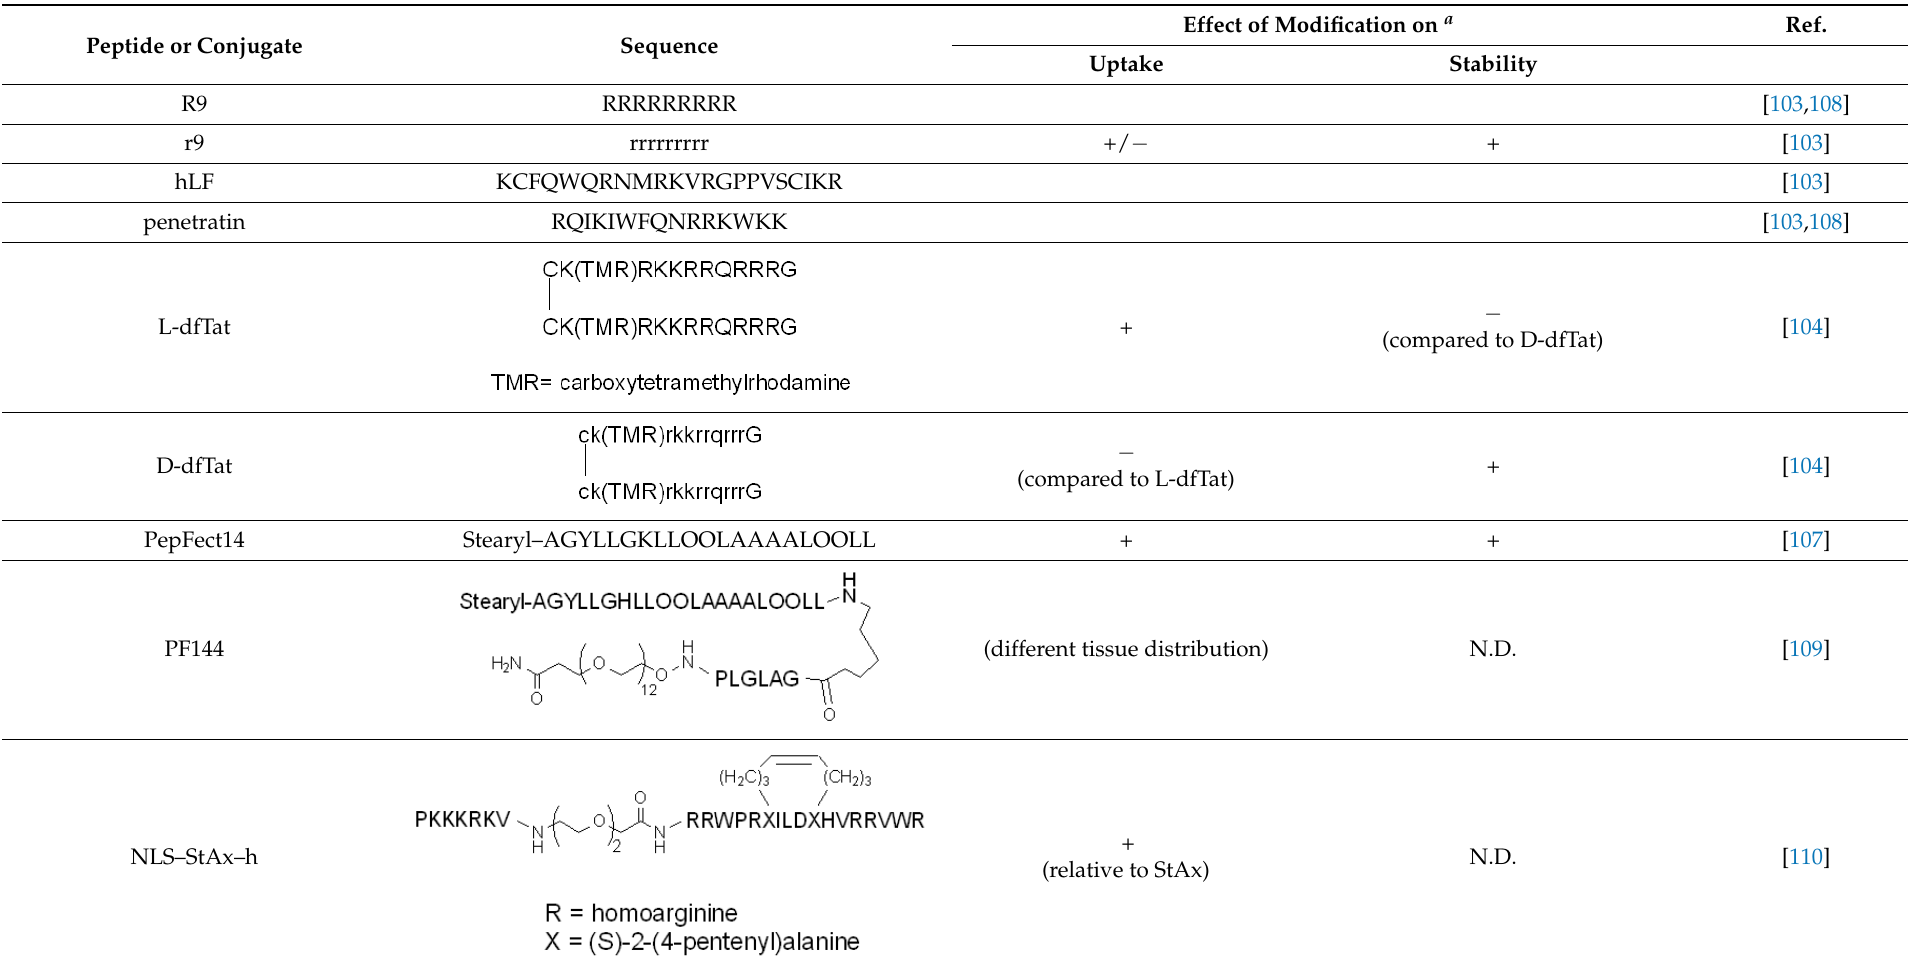
Table 1. Cell-penetrating peptides and their derivatives.